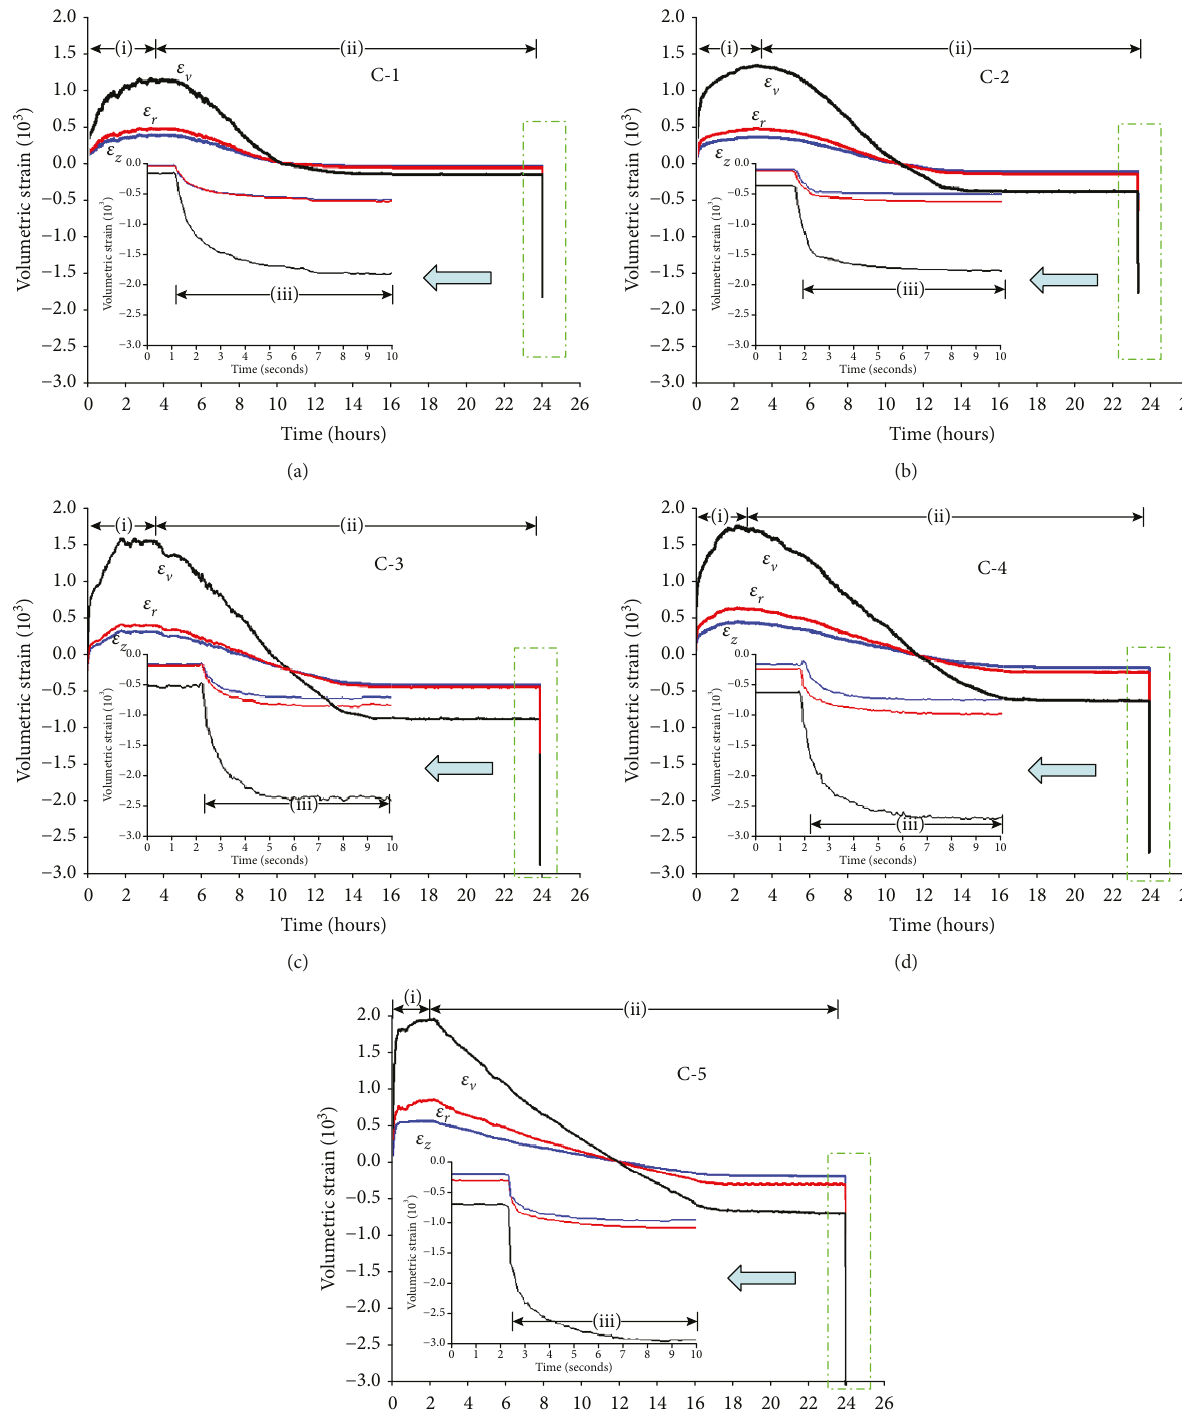
ε ε r , z , and v ) induced in coal samples during sorption-sudden unloading of